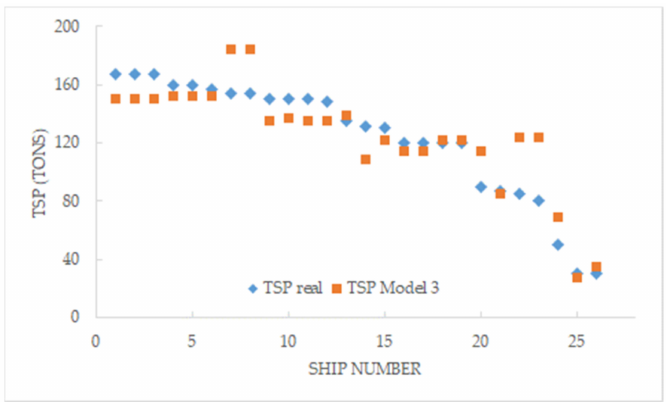
Figure 3. Representation of tugs’ TSP real and obtained with Model 3.